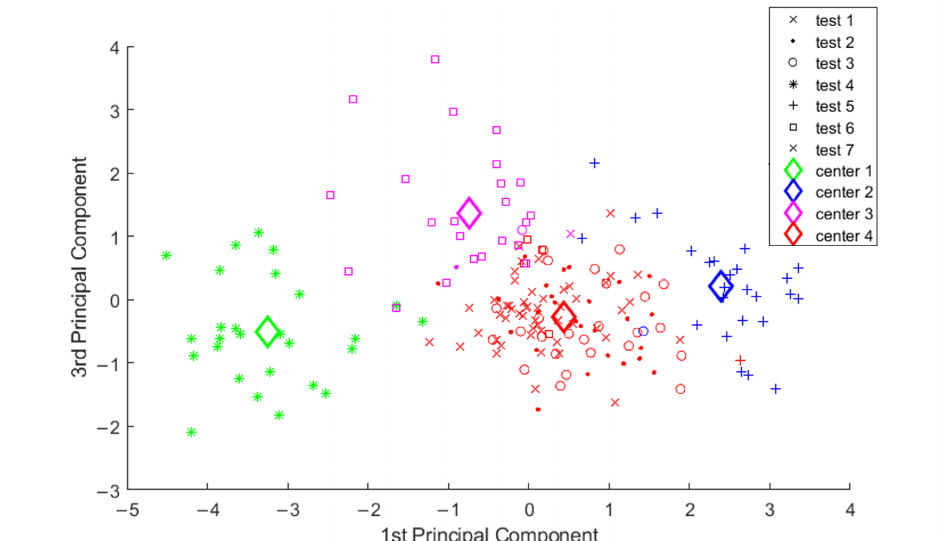
Figure 10. Clusters and cluster centers visualized in the plane of the two principal